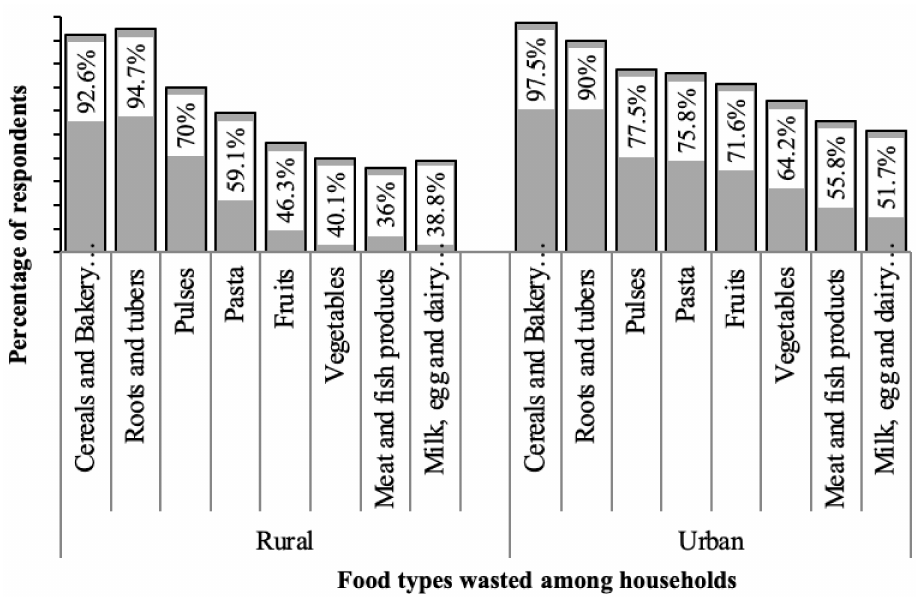
Figure 2. Distribution of common food types wasted among households in the study